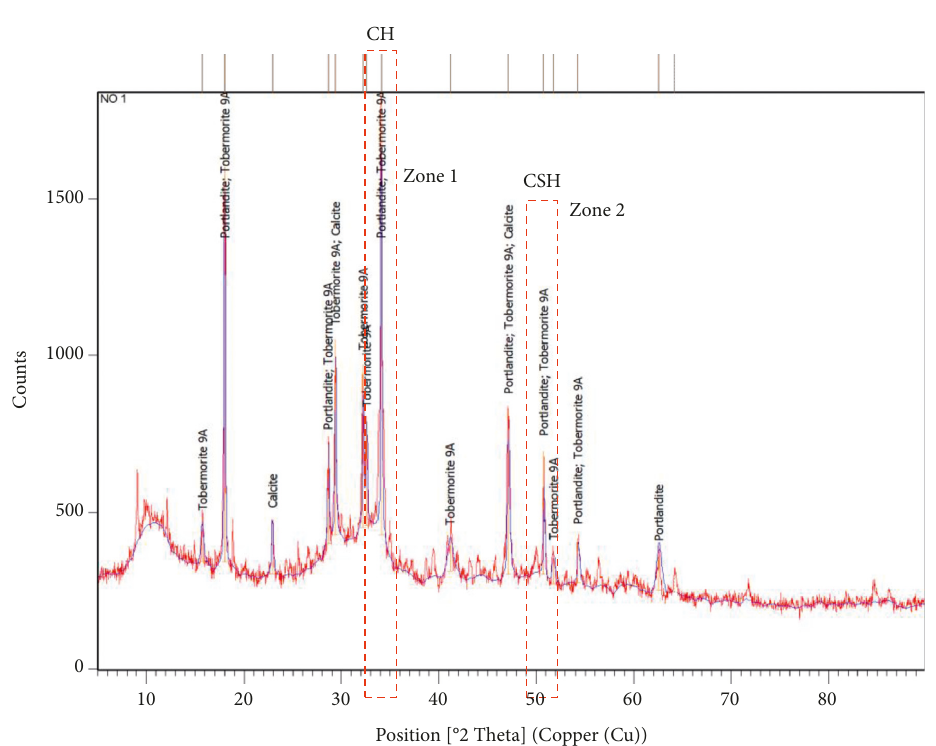
Figure 4: Compound scanning using X ′ pert highscore